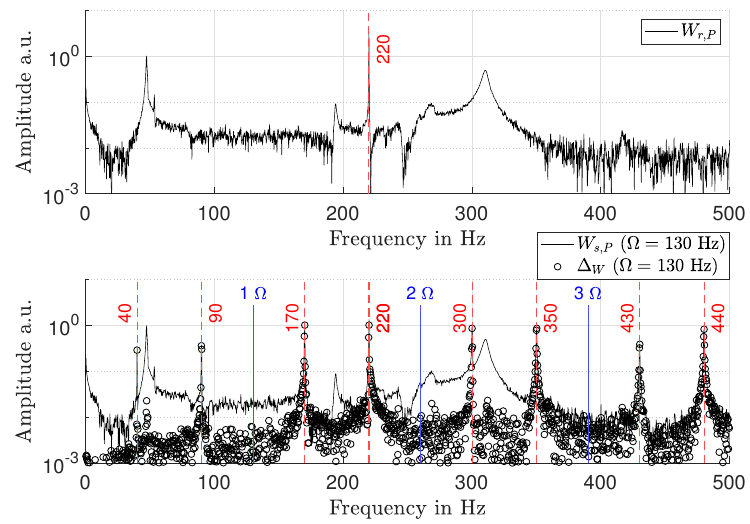
Figure 4. Top : rotating frame response spectrum W r , P with a superposed sine function at 220 Hz. Bottom : RSFM spectrum W c , P and measurement deviation ∆ W at Ω = 130 Hz. The added sine function at 220 Hz has a random phase at every consecutive